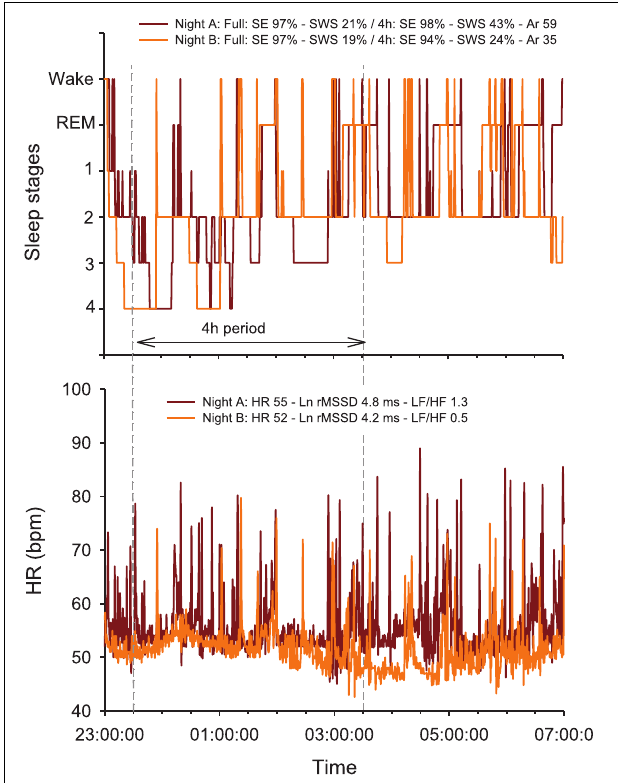
FIGURE 1 | Overnight hypnogram and heart rate (HR) patterns during two nights subjectively rated as very good (i.e., 5/5 on a 5-point scale) by a 25-year old team sport athlete. Physical activity (no intense exercise) preceding each night was similar (resting day,